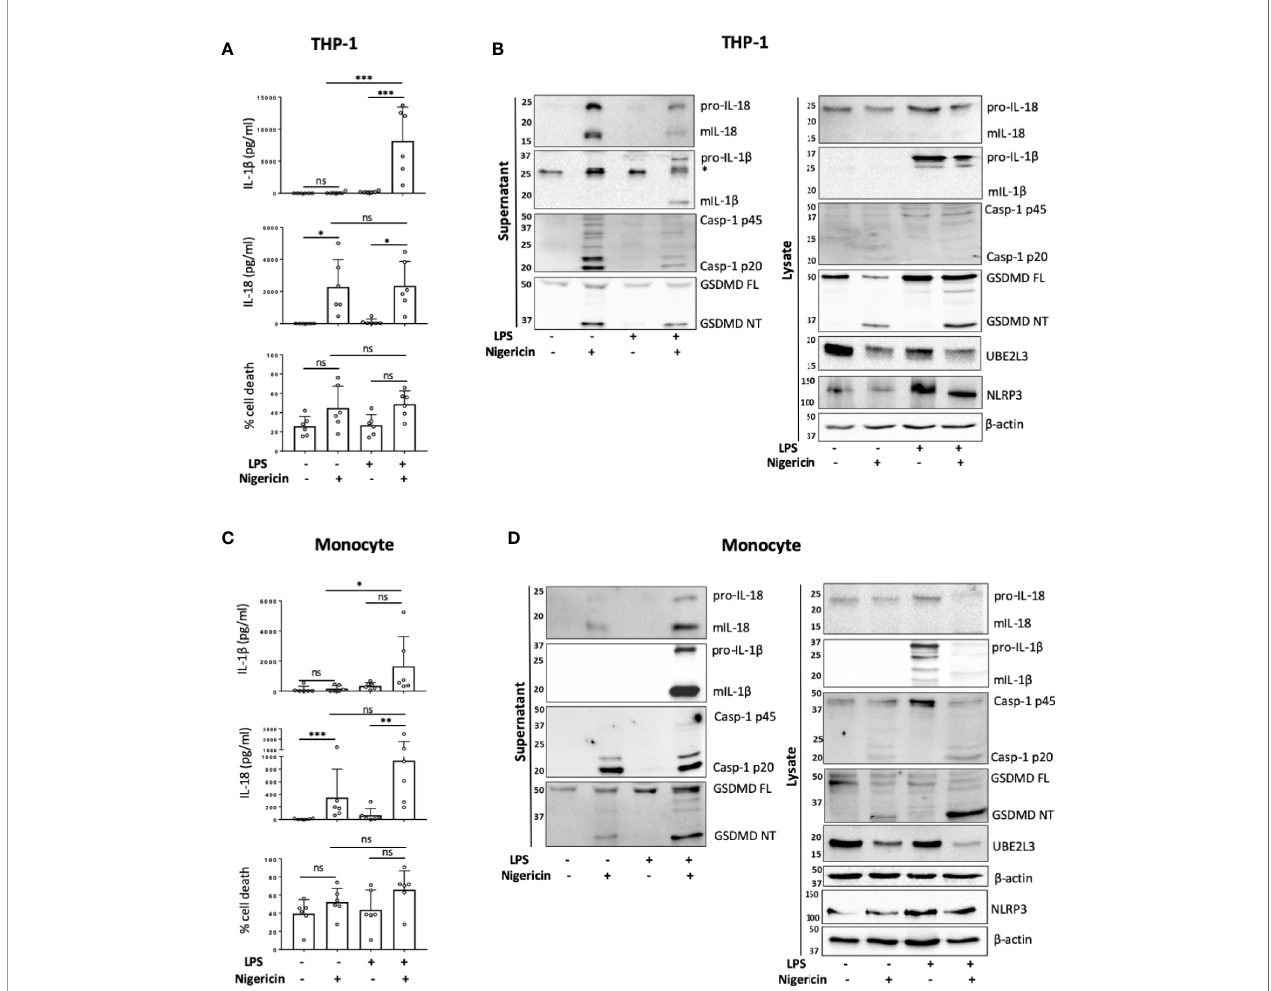
FIGURE 1 | Priming is not required for NLRP3 in fl ammasome activation in human monocytes in vitro . (A, B) Undifferentiated THP-1 cells (n=6 independent biological replicates) and (C, D) primary CD14 + monocytes (n=6 independent biological replicates (each point represents a different blood donor)) were left untreated or primed with LPS (1 µg/ml, 4 h) prior to treatment with nigericin (10 µM, 45 min) to activate the NLRP3 in fl ammasome. (A, C) IL-1 b and IL-18 were measured by ELISA and cell death was measured by LDH assay and shown as percentage relative to total cell death, mean ± S.D., *P < 0.05; **P < 0.01; ***P < 0.001; ns (non signi fi cant) using one-way ANOVA comparing all groups. (B, D) Western blot analysis for mIL-18 (18 kDa), pro-IL-18 (24 kDa), mIL-1 b (17 kDa), pro-IL-1 b (34 kDa), mCaspase- 1 (20 kDa), pro-Caspase-1 (45 kDa), GSDMD full length (FL, 53 kDa), GSDMD N-terminus (NT, 31 kDa), UBE2L3 (17.9 kDa), NLRP3 (113 kDa), as well as loading control b -actin (42 kDa). Blots are representative of at least 3 independent biological experiments and in case of monocytes 3 different blood